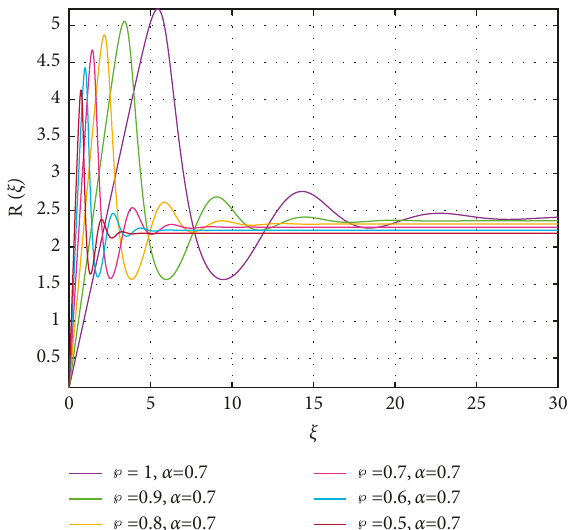
Figure 9: Displays of individuals who quit or not using Q ( ζ ) employing the Newton polynomial approach for decreasing fractal- dimension ℘ and fixed α � 0 .